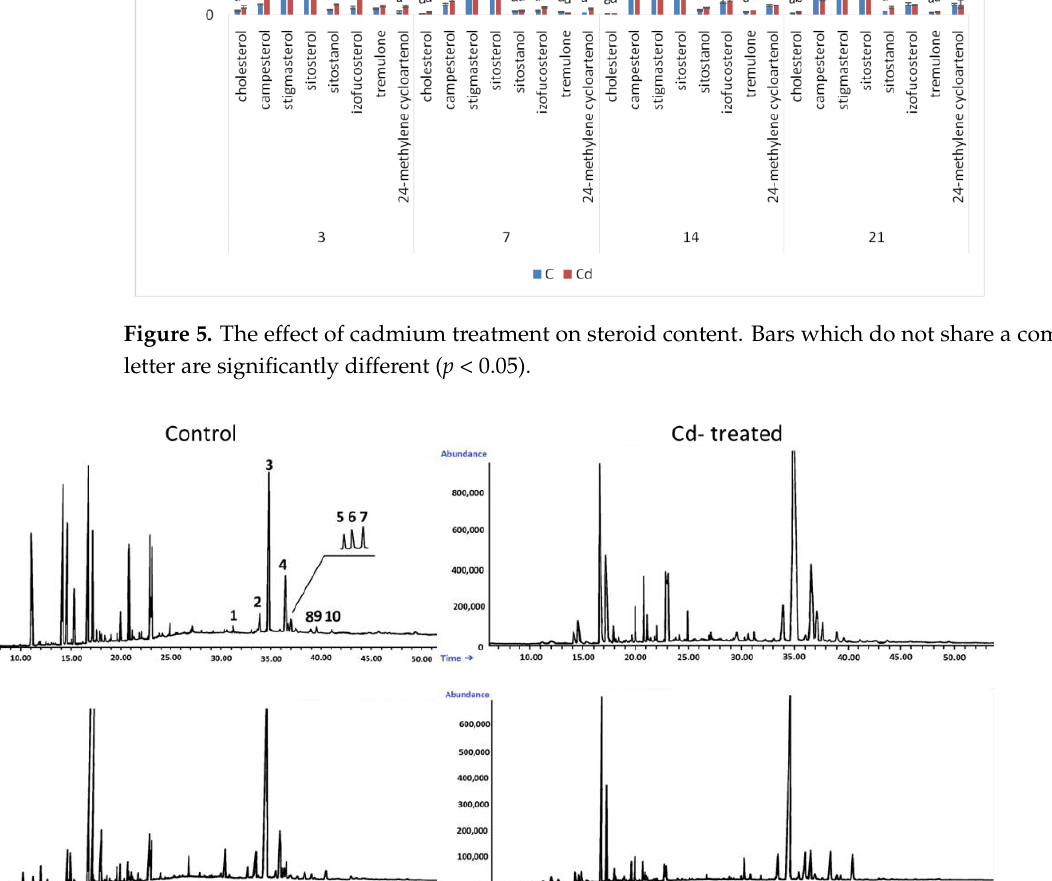
Figure 6. Representative chromatograms of the fractions containing free steroids from diethyl ether extracts obtained from control and cadmium-treated hairy roots after 3 and 14 days: 1, cholesterol; 2, campesterol; 3, stigmasterol; 4, sitosterol; 5, sitostanol; 6, isofucosterol; 7, β - amyrin; 8, α -amyrin; 9, tremulone; 10, 24-methylenecycloartanol.